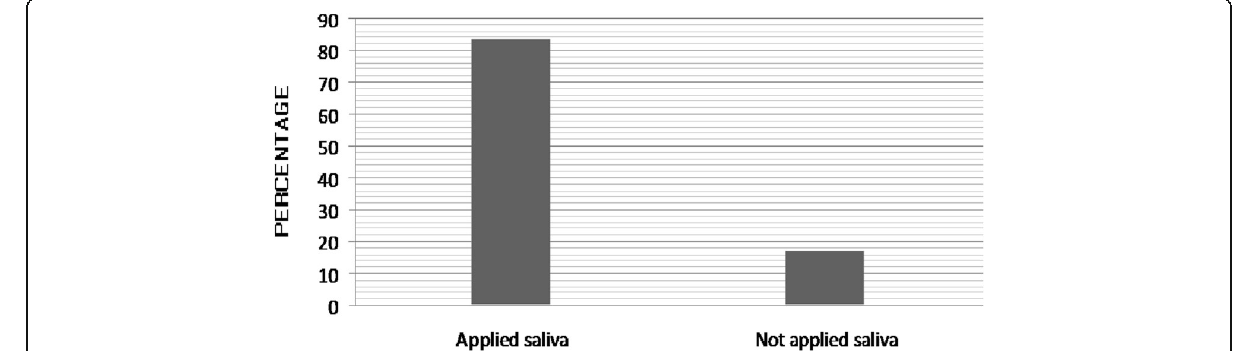
Fig. 1 Proportion of individuals who applied saliva on paper